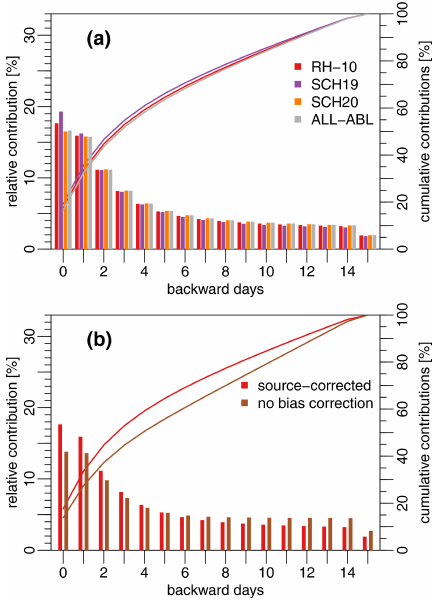
Figure 6. Relative (bars) and cumulative (lines) backward day con- tributions to heat advection (a) comparing the detection criteria and (b) illustrating the bias correction impacts, averaged over all cities and the period 1980–2016. The red bars and lines show the same setting (RH-10 and source-corrected contributions) in both panels. The brown bars in (b) refer to the same criteria (RH-10) but are not bias-corrected.